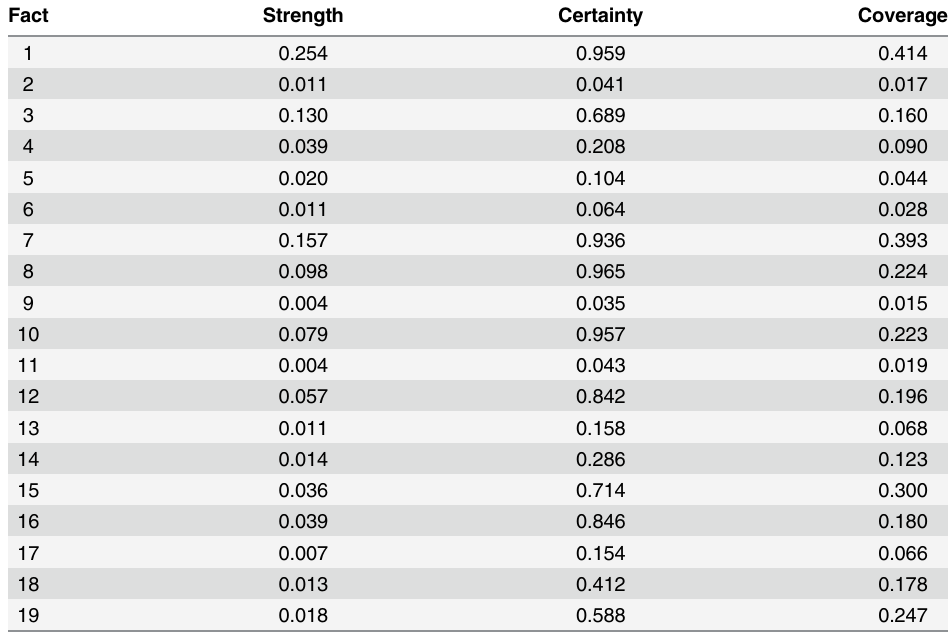
Fig 11 above shows conflict graph among all Indonesian parties, solid lines are denoting conflicts, dotted lines are in alliance, and party which is not connected to other parties is neu- tral, for simplicity, in this case is Demokrat. Thus, in this case the final decision regarding gov- ernor election model in Indonesia i.e. indirect method. Table 21. The Strength, Certainty, and Coverage, of Indonesian Parties Voting result.